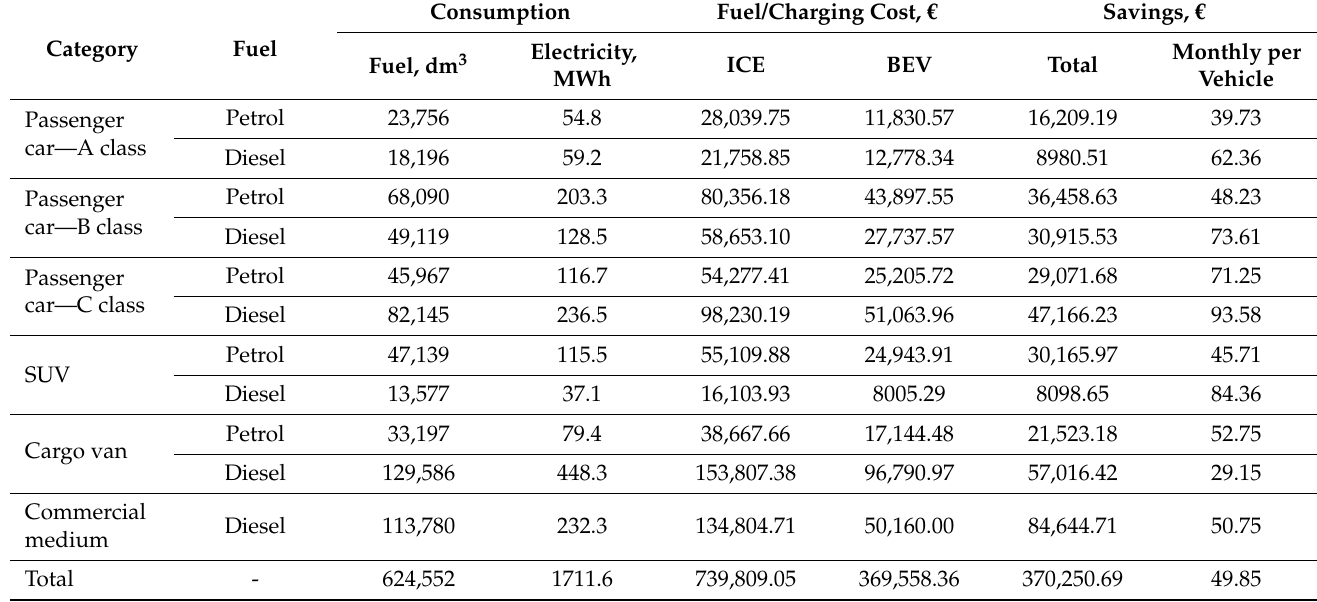
Table 4. Operational costs and savings analysis for ICE to BEV conversion.